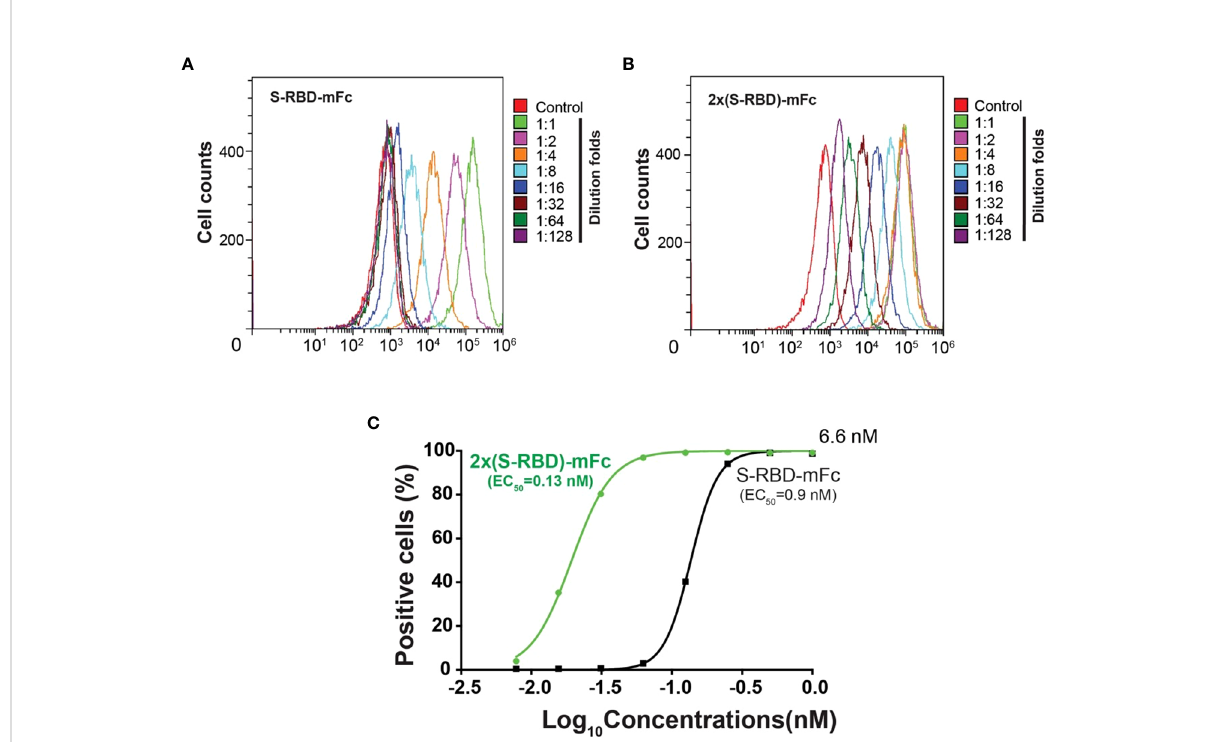
FIGURE 3 Af fi nity between hACE2 and the S RBD -mFc and the 2xS RBD -mFc. (A, B) Flow cytometry diagrams show the S RBD -mFc and 2xS RBD -mFc of binding to human ACE2 expressed on the HEK293T cell surface at a 2-fold series dilution. (C) Af fi nity binding curves for S RBD -mFc or 2xS RBD -mFc fusion proteins were established based on the fl ow cytometry